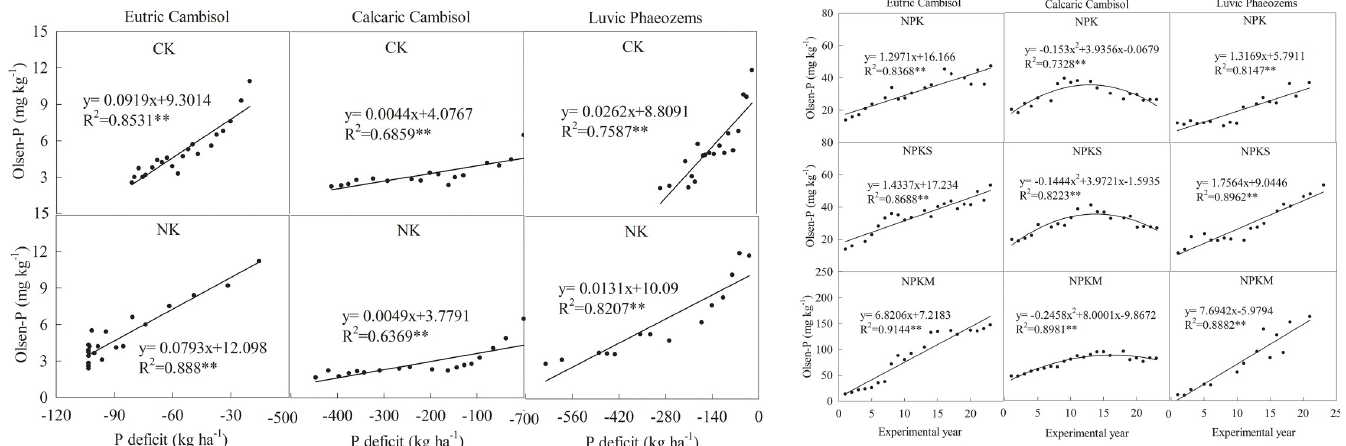
Fig 4. Response of soil Olsen-P to the soil P budget under different long-term fertilizer application treatments. CK: unfertilized control; NK: nitrogen and potassium; NPK: nitrogen, phosphorous, and potassium; NPKS: nitrogen, phosphorous, potassium and straw; and NPKM: nitrogen, phosphorous, potassium and manure